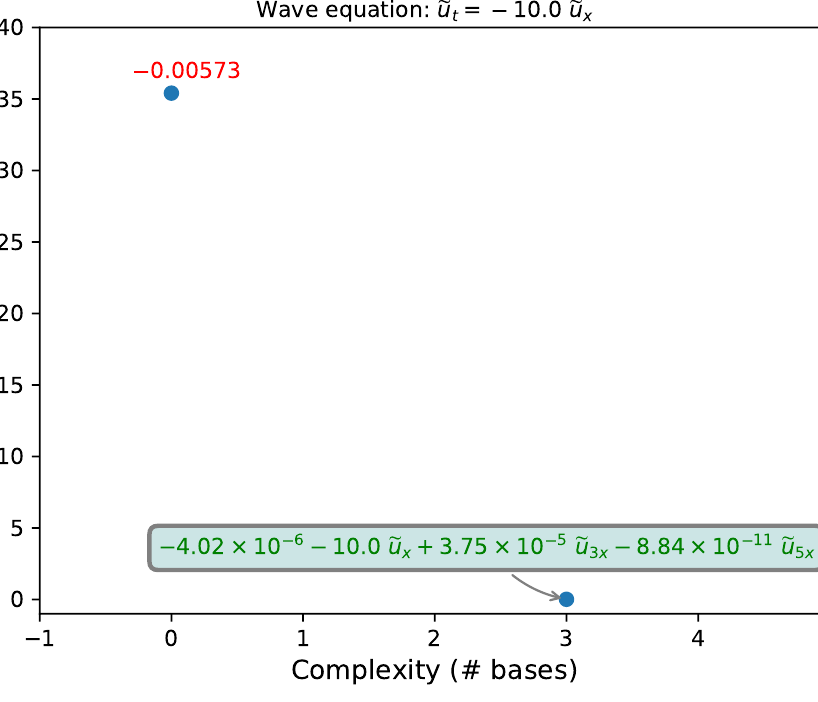
Figure 3. Predicted models with varied test error and complexity for wave